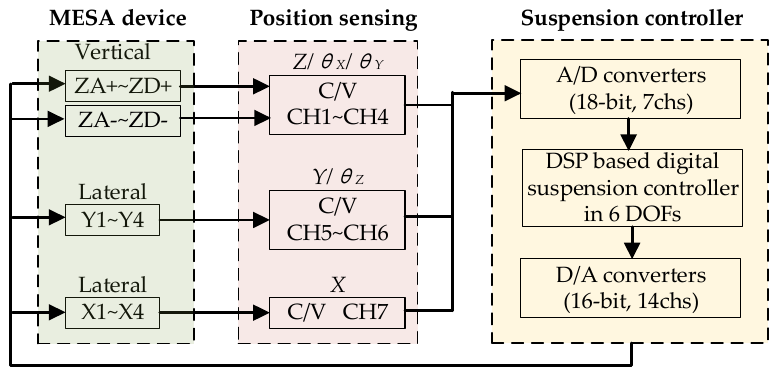
Figure 3. Schematic of the MESA suspension control system with six DoFs.